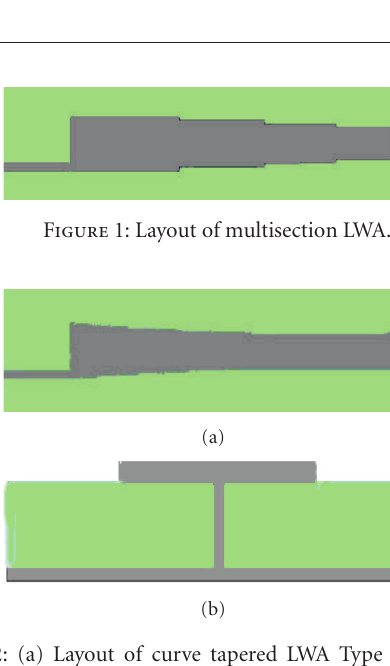
Figure 2: (a) Layout of curve tapered LWA Type II. (b) Cross- section of LWA Type II with a physical grounding structure along the length of the antenna which connects the conductor strip and the ground plane.